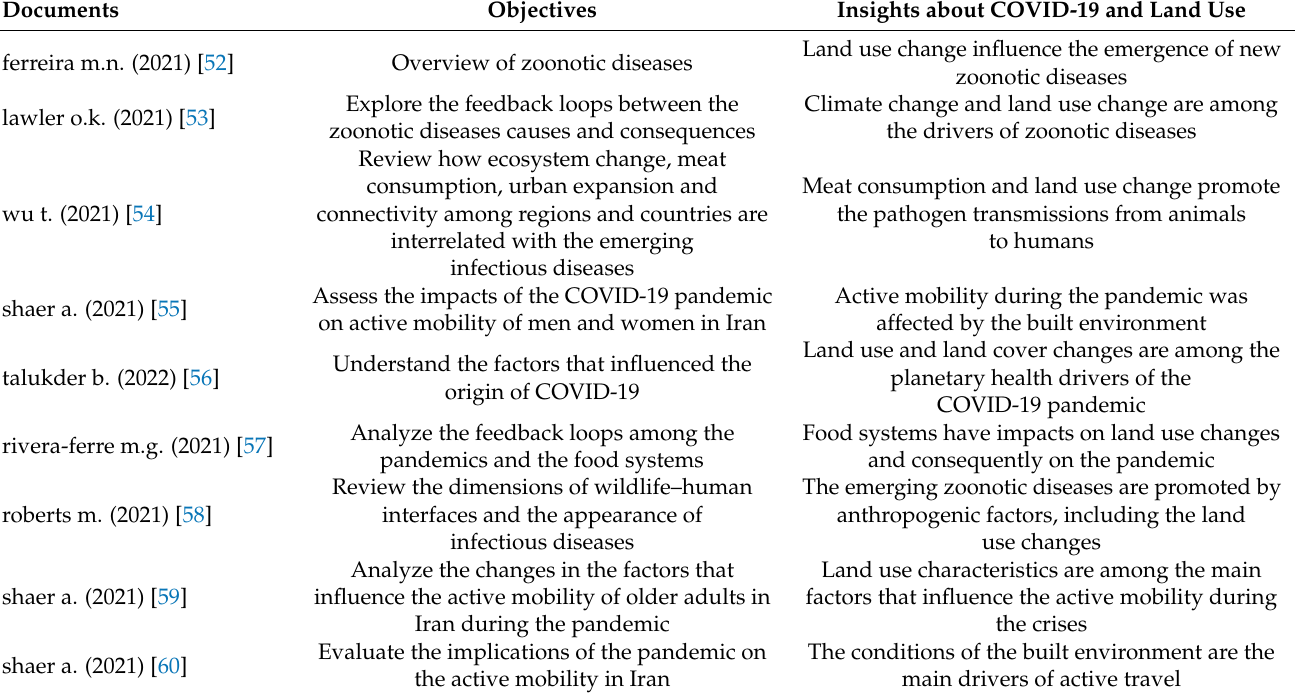
Table 4. Contributions from the top 20 documents with the highest total link